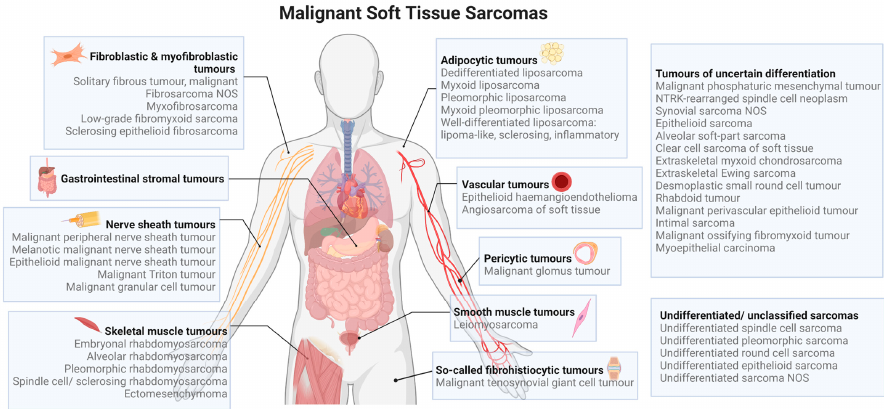
Figure 1. Types of soft tissue sarcomas based on the 2020 WHO classification [15].